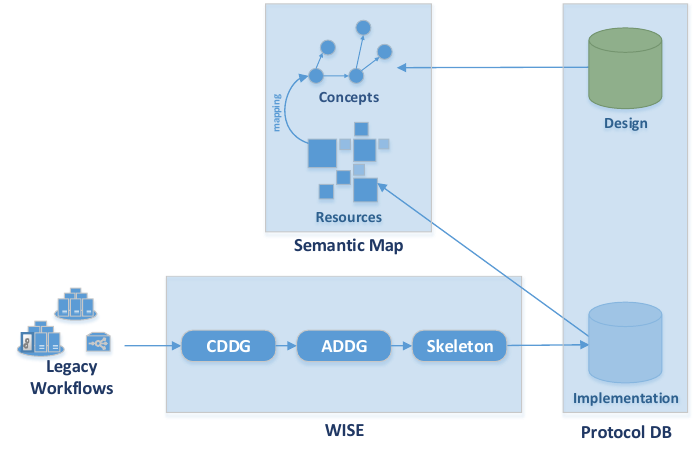
Figure 1: Overall